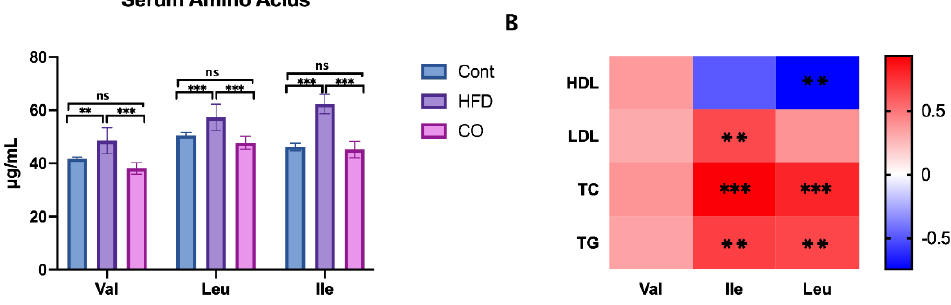
Figure 2. Effect of CO treatment on serum levels of BCAA in HFD-fed mice. ( A ) the concentration of BCAA in serum; data are expressed as the mean ± SEM ( n = 10), ** p < 0.01, *** p < 0.001, ns p > 0.05; ( B ) the Spearman’s correlation analysis was conducted between serum lipid biomarkers and serum BCAA concentration, and the correlation coefficient was used for the heat map: **, p < 0.01; ***, p < 0.001.